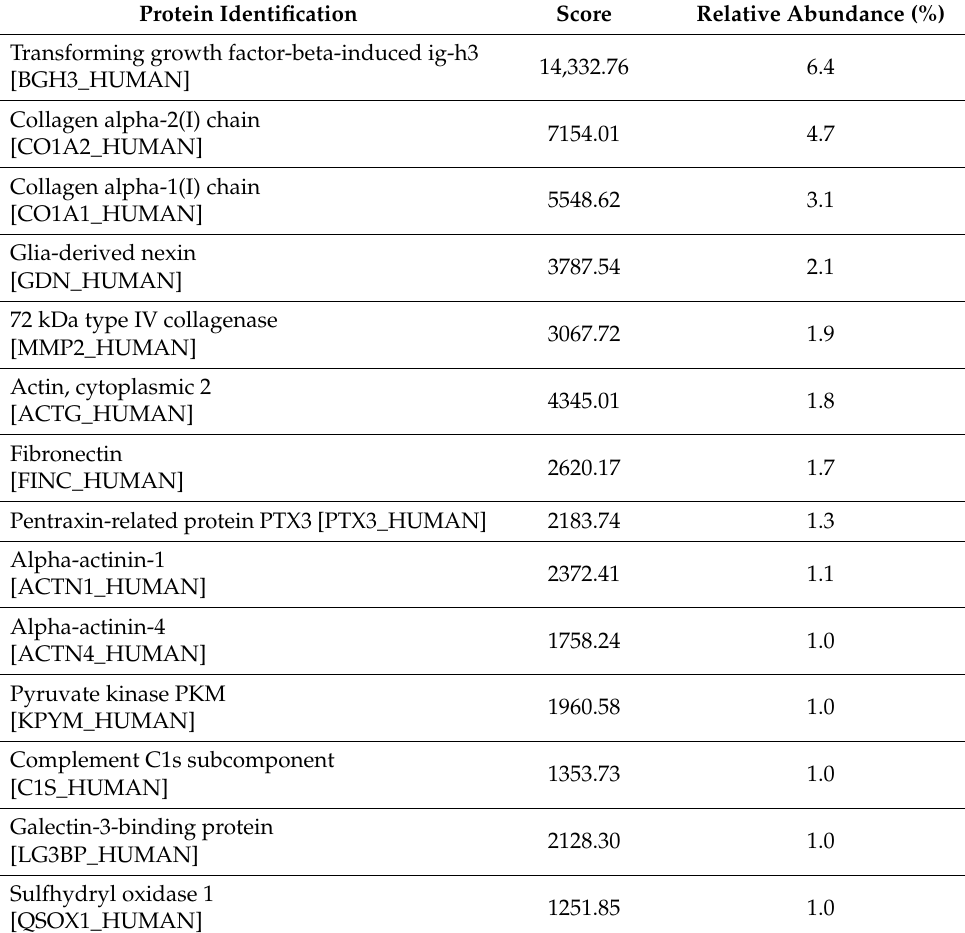
Table 1. Proteomic analyses of mesenchymal stem cell exosomes. Protein